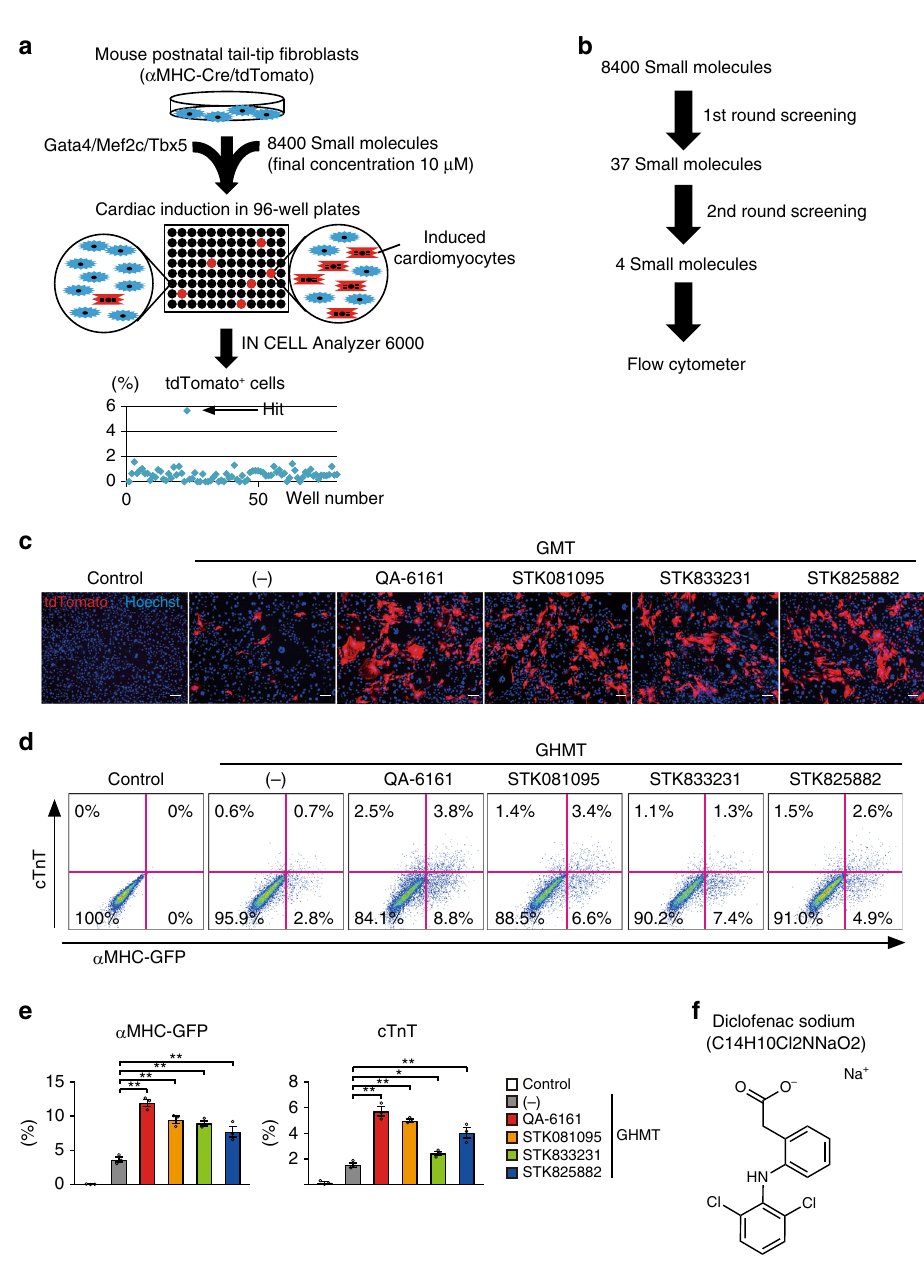
Fig. 1 High-content screening identi fi es small molecules for cardiac reprogramming. a , b Schematic representation of the high-content, high-throughput screening system designed to identify small molecules for cardiac reprogramming in α MHC-Cre/R26-tdTomato TTFs in the presence of GMT. After the second screening, FACS was performed ( b ). c Four compounds increased generation of α MHC-Cre/R26-tdTomato + cells from postnatal TTFs after 1 week. See also Supplementary Table 2. d , e FACS analyses for α MHC-GFP and cTnT expression in GHMT-transduced TTFs treated with indicated compounds for 1 week. Quantitative data are shown in e ; n = 3 biologically independent experiments. See also Supplementary Figure 1. f Chemical structure of diclofenac (QA-6161). One-way ANOVA with Dunnett ’ s post hoc test was performed for e ; all data are presented as mean ±SEM. * P < 0.05, ** P < 0.01 vs. the relevant control. Scale bars represent 100 μ